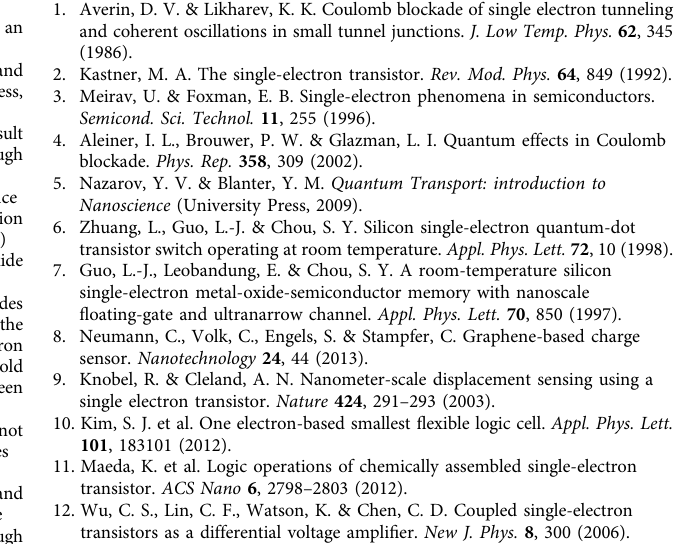
Fig. 6. The success of the electrodeposition process crucially depends on the symmetry of the distance between the dot and the leads. If the metallic colloid is not positioned at the center of the gap, there is a very small chance to stop the electrodeposition process at measured conductance of G ≤ e 2 / h while still being able to observe CB effects. Twenty- fi ve percent of our electrodeposited samples showed CB effects while the rest showed ohmic conductance curves, apparently due to strong antisymmetric geometry. An example of such asymmetric device is shown in Fig. 6c. In this case, when measurable current appeared through the device, the dot was already fully connected to the right electrode, and therefore no CB effects were resolved.